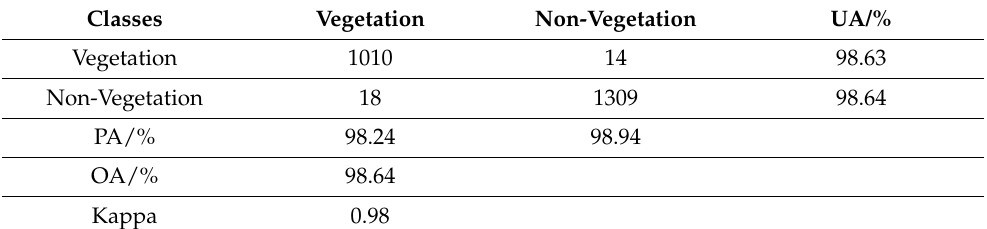
Table 6. Classification Confusion Matrix and Classification